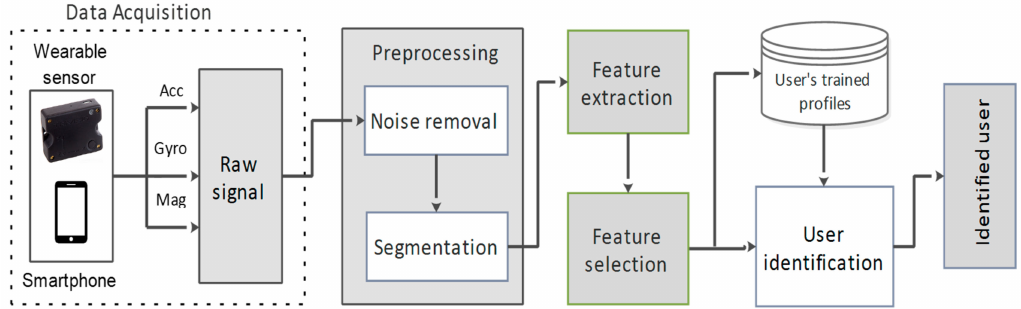
Figure 1. The proposed methodology for user